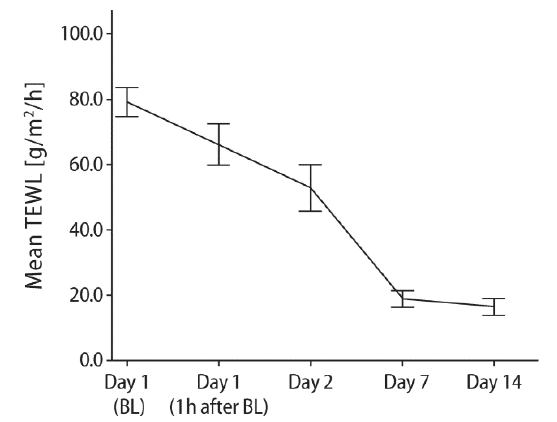
Table 1. Mean change from baseline in transepidermal water loss (TEWL) following application of